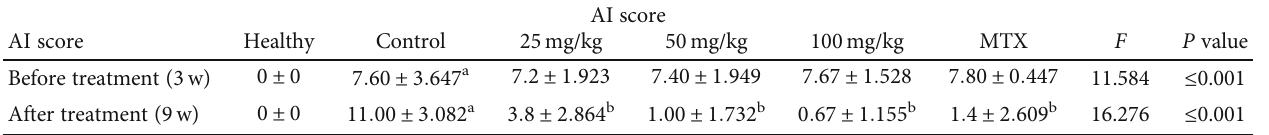
Table 2: E ff ects of matrine on changes in the AI score for arthritis in the CIA rats.